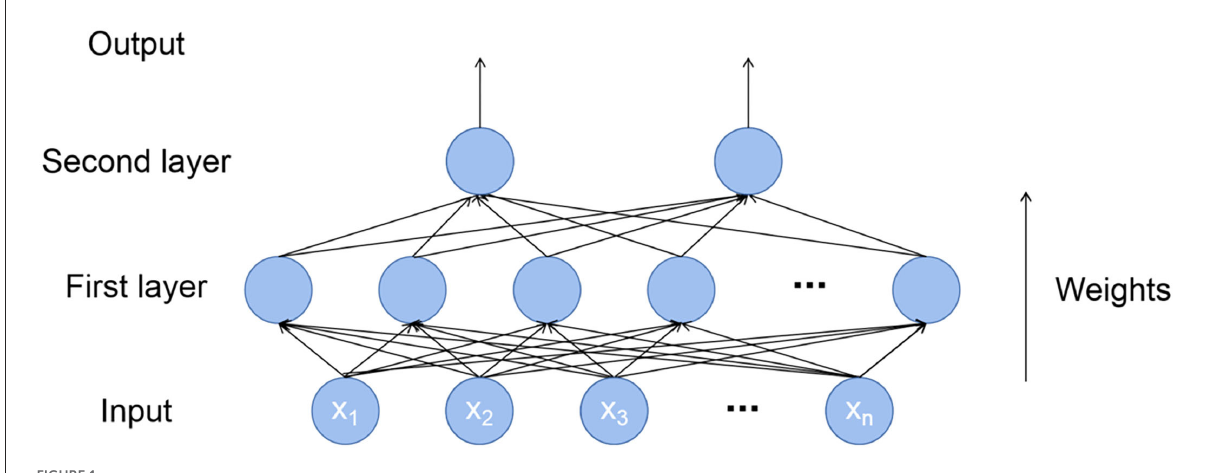
FIGURE1 Structure of artificial neural network model